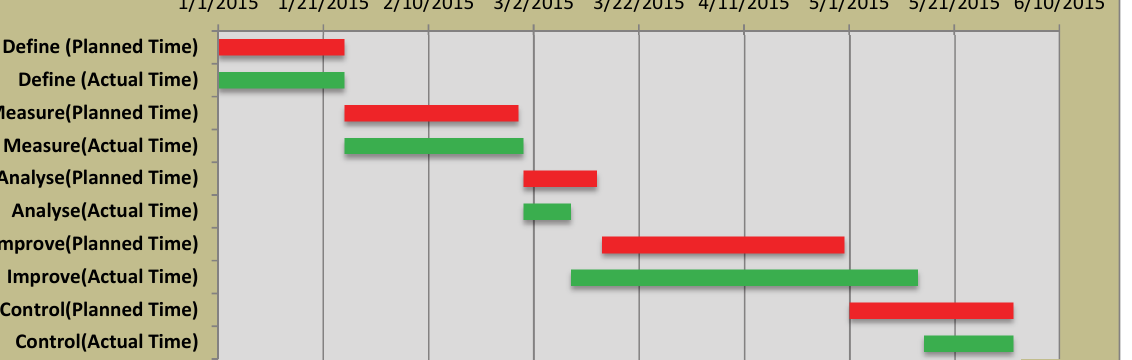
Fig. 7. Six Sigma Project Plan (Gantt Chart)